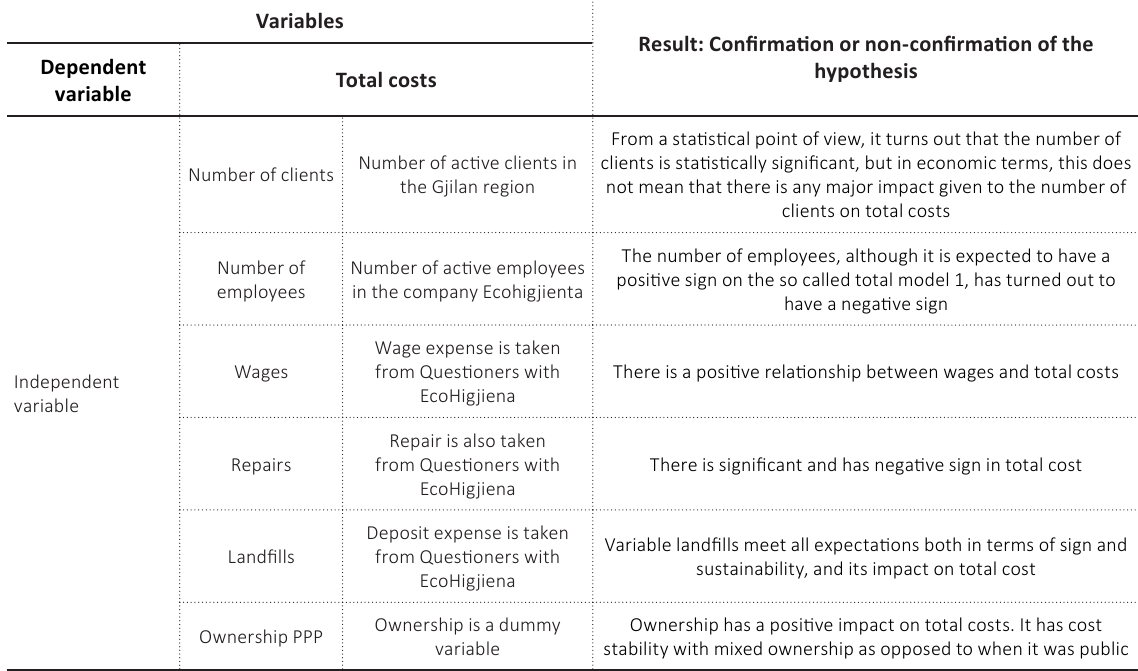
Table 5. Description of the independent variables and the results obtained